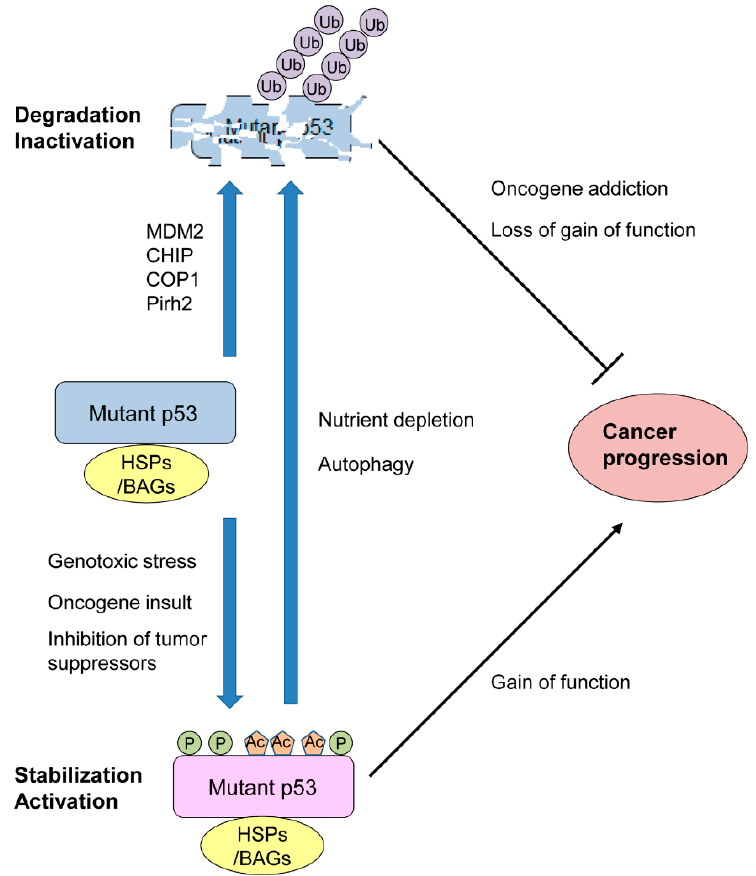
Figure 2. Environmental stresses alter stability and activity of mutant TP53 (mutp53) crucial for its oncogenic gain of function (GOF).